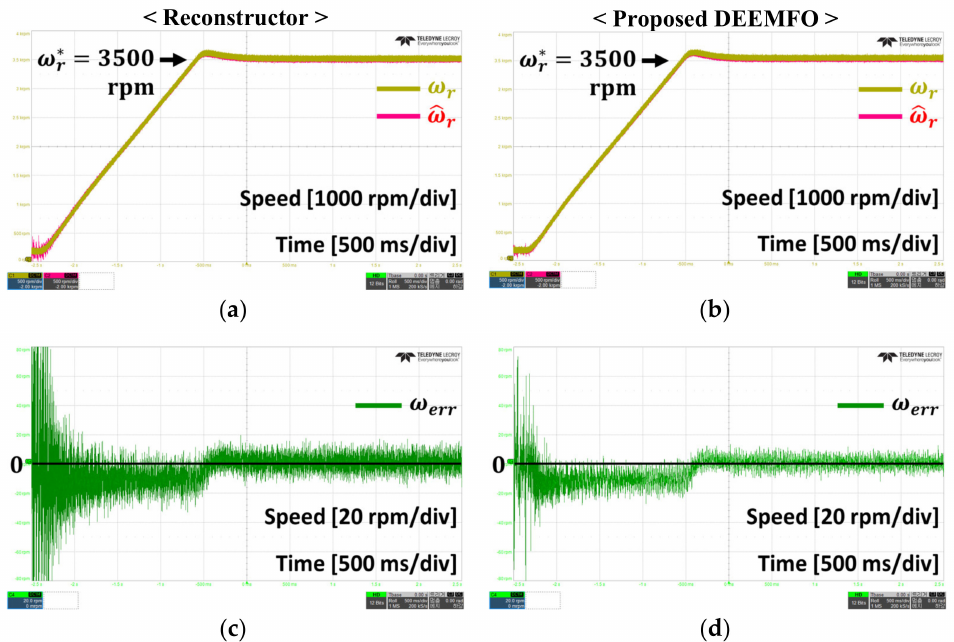
Figure 14. Summary of the experiment results under no load condition. ( a ) reference, real, and estimated speed with reconstructor; ( b ) reference, real, and estimated speed with DEEMFO; ( c ) speed error in reconstructor; ( d ) speed error in DEEMFO.